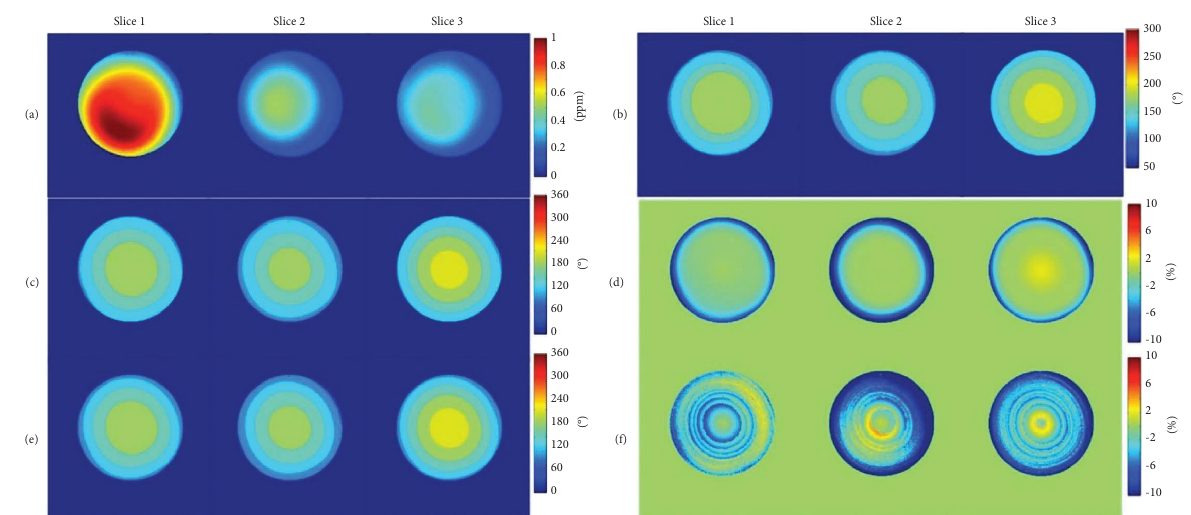
Figure 6: Resulting phase of the proposed B 1 mapping method and multislice ISI mapping method with the phantom. (a) B 0 inhomogeneity maps. (b) Resulting phase maps and (c) the resulting phase maps corrected for B 0 inhomogeneity for the proposed B 1 mapping method. (d) Error values before and after B 0 inhomogeneity corrections for the proposed B 1 mapping method. (e) B 1 maps calculated using the multislice ISI mapping method. (f) Error values between the proposed B 1 mapping method and multislice ISI mapping